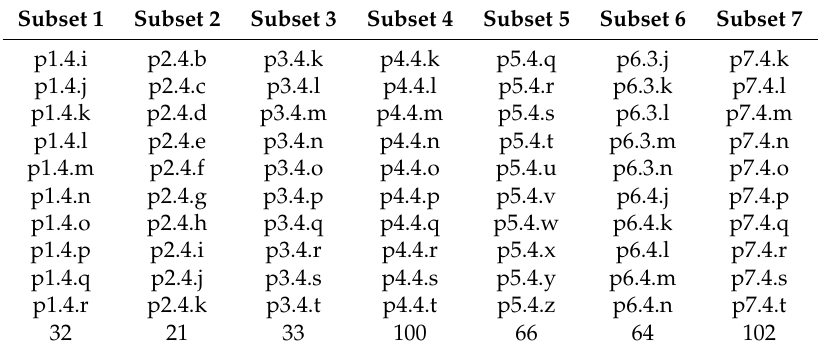
Table 1. Classical team orienteering problem (TOP) instances from Chao et al. [1] used in our experiments. Subset 1 Subset 2 Subset 3 Subset 4 Subset 5 Subset 6 Subset